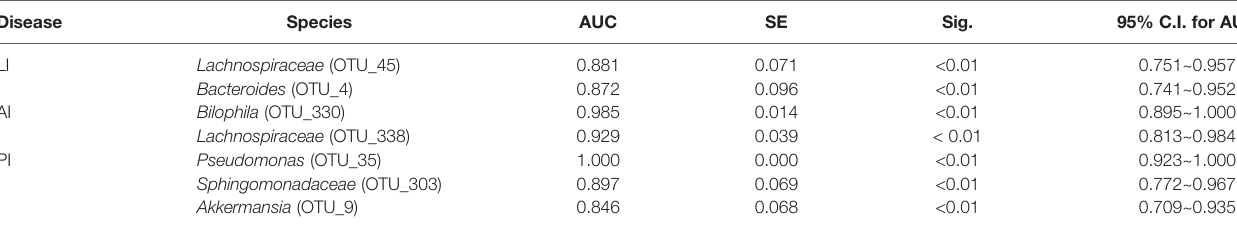
TABLE 2 | Diagnostic values of signi fi cant gut microbiota for acute ischemic stroke. Disease Species AUC SE Sig. 95% C.I. for AUC